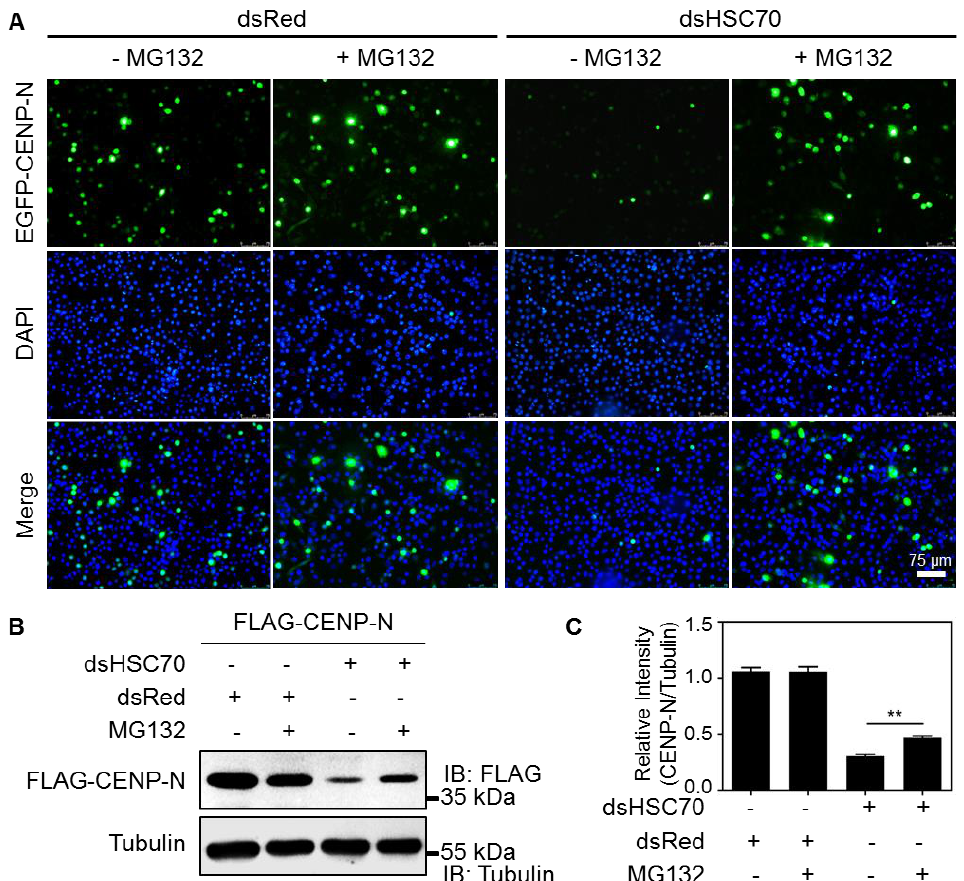
Figure 4. Stability of CENP-N via interaction with HSC70 chaperone. ( A ) Representative images of silkworm cells expressing EGFP-CENP-N under different treatments. CENP-N was labeled with EGFP fluorescence (green) and the nuclear DNA were stained with DAPI (blue). Scale bar, 75 μm. ( B ) Representative immunoblotting images of silkworm cells expressing FLAG-CENP-N under different treatments. CENP-N was detected using an anti-FLAG antibody and the expression of tubulin was used as an internal control. “ + ” represented the addition of designated dsRNA and MG132, and “-” represented the non-addition of dsRNA and MG132. ( C ) Quantification of FLAG-CENP-N expression levels using Image J software. “ + ” represented the addition of designated dsRNA and MG132, and “-” represented the non-addition of dsRNA and MG132. Three independent replicates were analyzed and statistical significance was evaluated by GraphPad Prism 5 (** p <